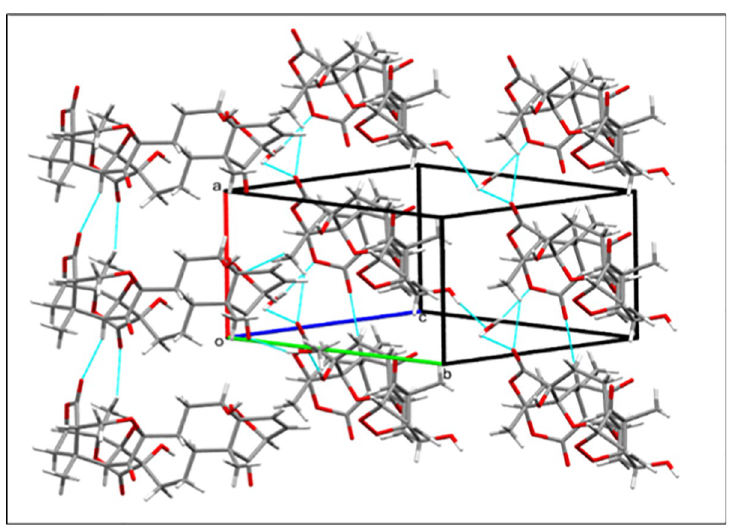
Fig 7. Crystal packing diagram of compound 8.